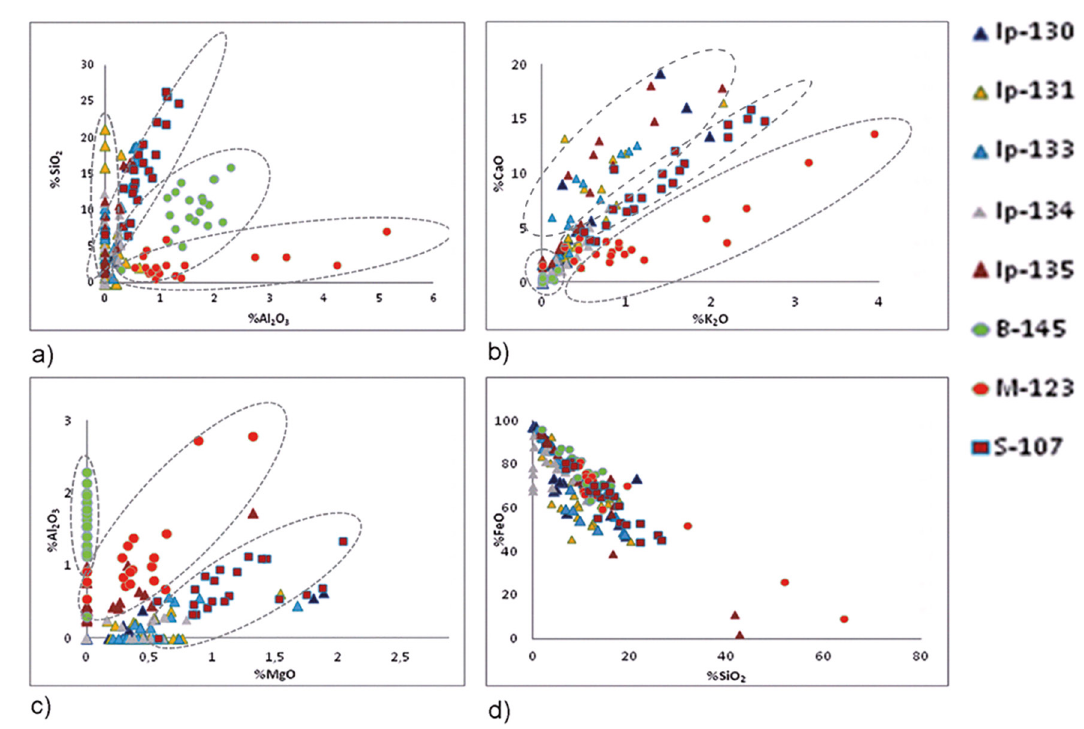
versus %Al O ; 2 2 3